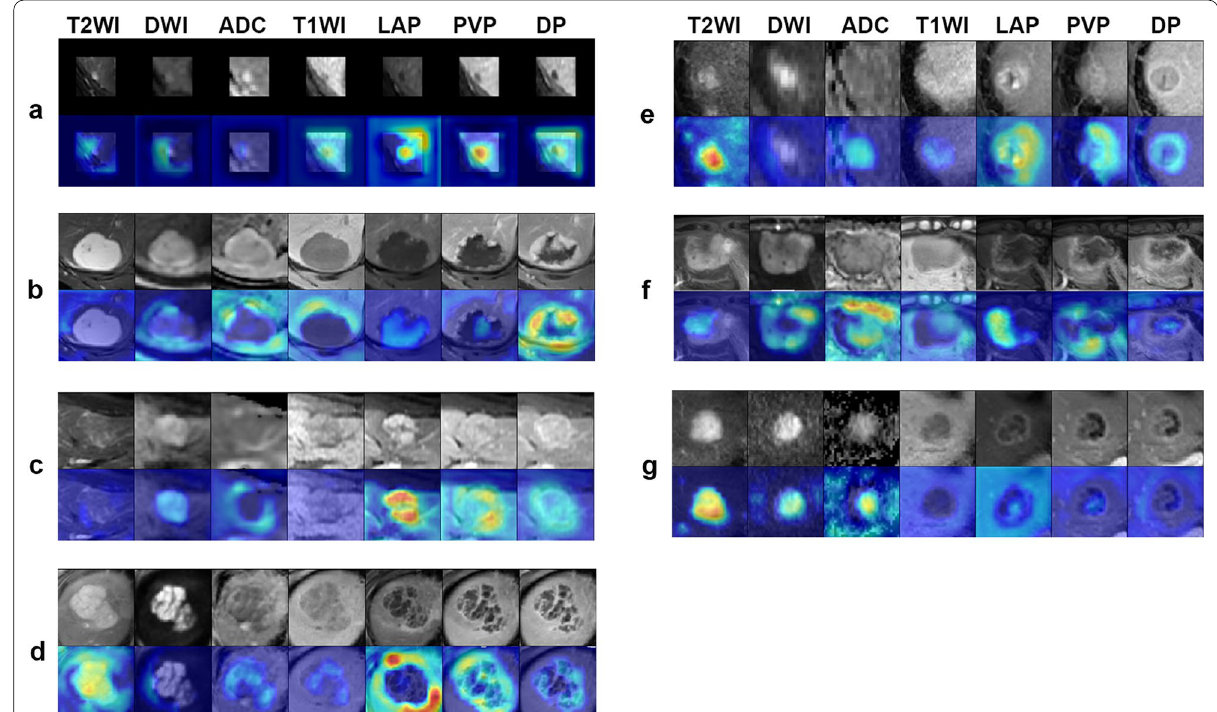
Fig. 6 Saliency map for example images from 7 category classifications of the test set. Red highlights the activation region of the weight of each sequence/phase in differential diagnosis. ( a ) Cyst, ( b ) HEM, ( c ) FNH, ( d ) HEP, ( e ) HCC, ( f ) ICC and ( g ) MET show good display, and these maps reveal that the importance of different sequences/phases in the analysis of each category of FLLs is